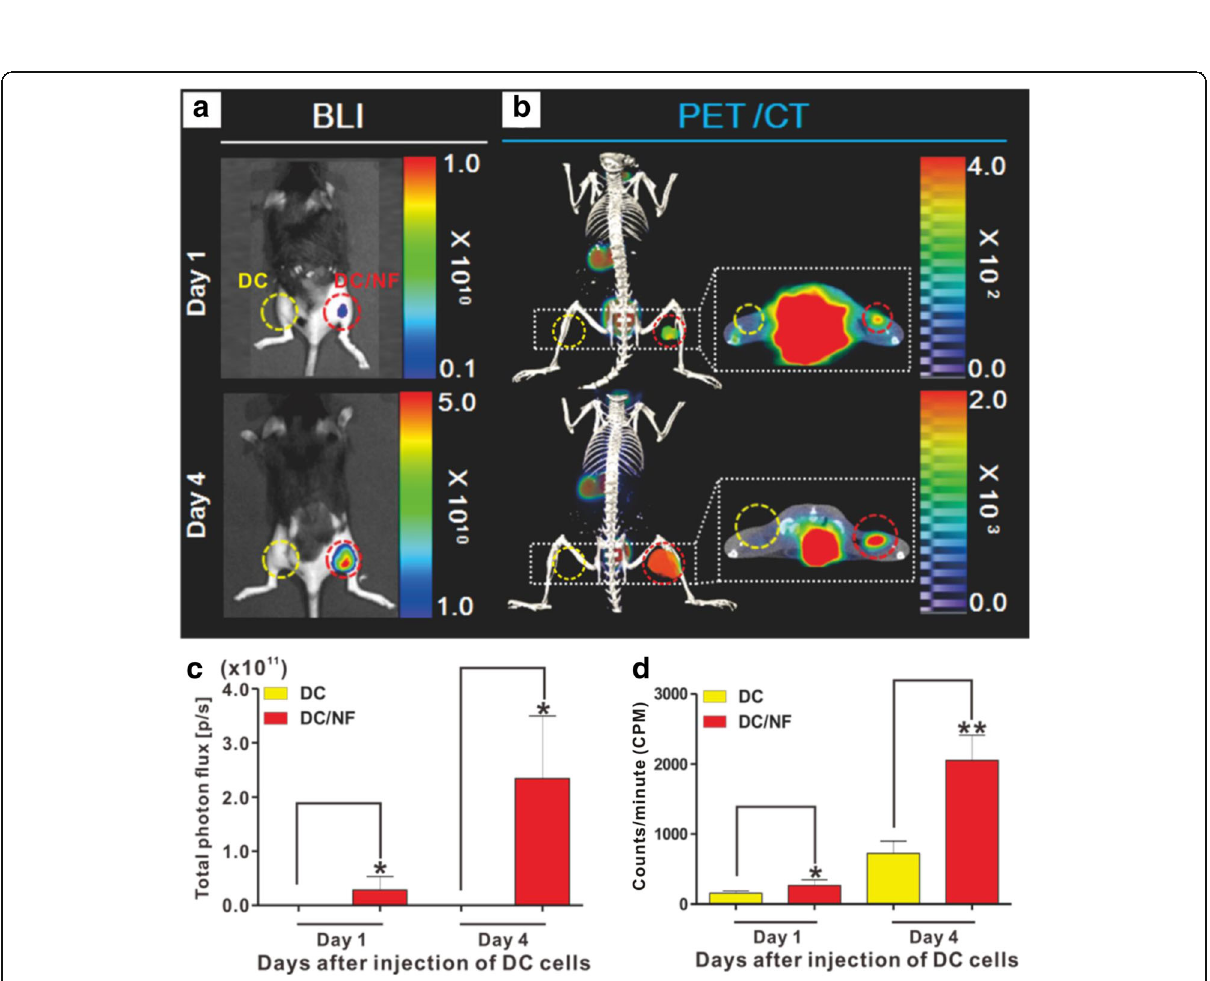
Fig. 4 In vivo 18 F-TFB PET/CT imaging and BLI of intramuscularly injected DCs. Parental DC and DC/NF cells were intramuscularly injected into the left and right thighs of mice, respectively, and combined 18 F-TFB PET/CT imaging and BLI was performed. a In vivo BLI and b 18 F-TFB PET/CT imaging of parental DC and DC/NF cells on days 1 and 4 after the intramuscular injection. The red and yellow circles indicate the DC and DC/NF injection sites, respectively. ROI analysis of c bioluminescent and d PET/CT images. Data are expressed as mean ± SD; n =